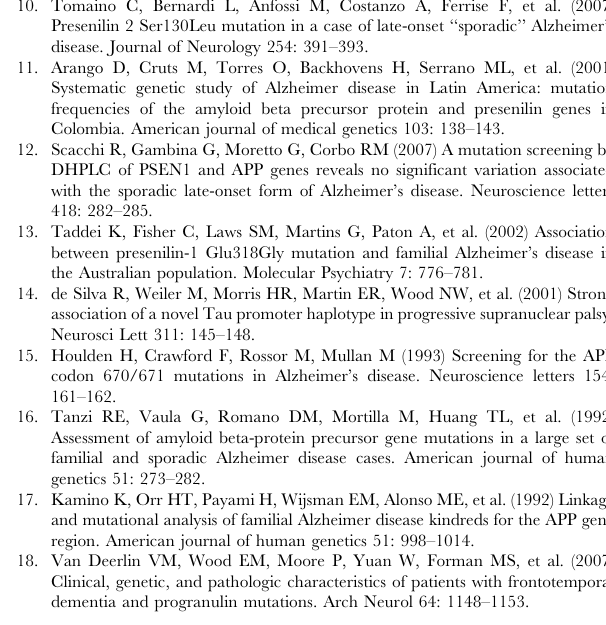
Figure S3 The number of affected individuals and the age at onset of the sequenced individual, but not gender or APOE genotype are associated with the presence of non-synonymous, nonsense or splice-site variants in the APP , PSEN1 , PSEN2 , MAPT or GRN genes. We used a logistic regression model to analyze the association of the number of affected individuals, the age at onset of the sequenced individual, gender and APOE genotype with the presence of sequence variants. The Odds Ratio (OR) and the 95% confidence interval were calculated. The risk of having a sequence variant in these genes increase by 1.33 (95%: 1.105–1.69) for every two affected individuals in the family. The risk of having a sequence variant in these genes decreased by 0.807 (95%: 0.67– 0.96) for every five years increase in age at onset. Figure S4 ROC curve for the logistic regression model including the number of affected individuals in a family and age at onset for the presence or absence of sequence variations in the APP , PSEN1 , PSEN2 , MAPT or GRN genes. We used a logistic regression model to generate a ROC curve including the variables that could predict the presence of a sequence variant in this series. A stepwise regression analyses was used to include the most significant variables among: APOE genotype, gender, age at onset and the number of affected individuals in each family. The logistic regression identified age at onset (p = 0.0008; Area under the Curve = 0.6022) in the first step and number of affected individuals (p = 0.0001; Area under the Curve =0.5779) in the second step. No other variable entered in the